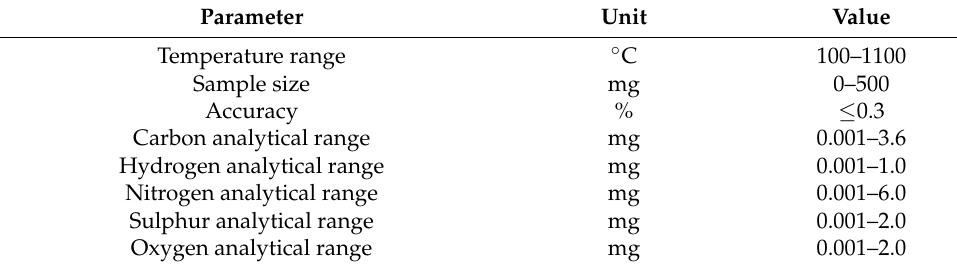
Table 4. Technical specification of PerkinElmer CHNS/0 2400 apparatus.